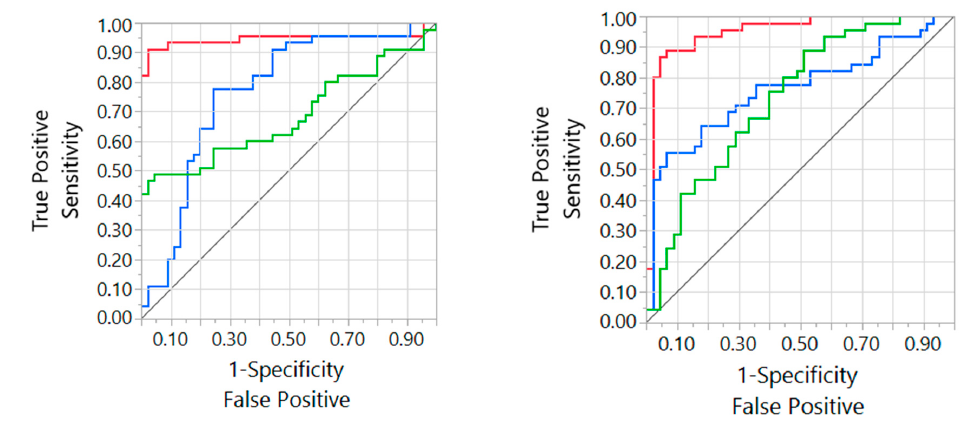
Figure A1. Receiver operating characteristic (ROC) curves of peak 2209 (left panel) and 234 (right panel) for the classifications Happy–Neutral (blue), Fear–Neutral (red), and Fear–Happy (green). For peak 2209 Neutral was the positive level for Happy–Neutral and Fear–Neutral, and Happy was the positive level for Fear–Happy. For 234 fear was the positive level for all three classifications.